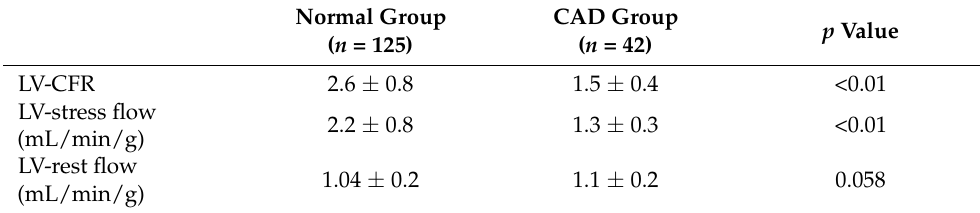
Table 3. The relationship of Dynamic SPECT/CT and cardiac catheterization in patients of this study. Dynamic SPECT/CT (Ischemic Extent of LV) Total (N) <8% ≥ 8% Normal 120 5 125 Cardiac Catheterization Abnormal 5 37 42 Total (N) 125 42 167